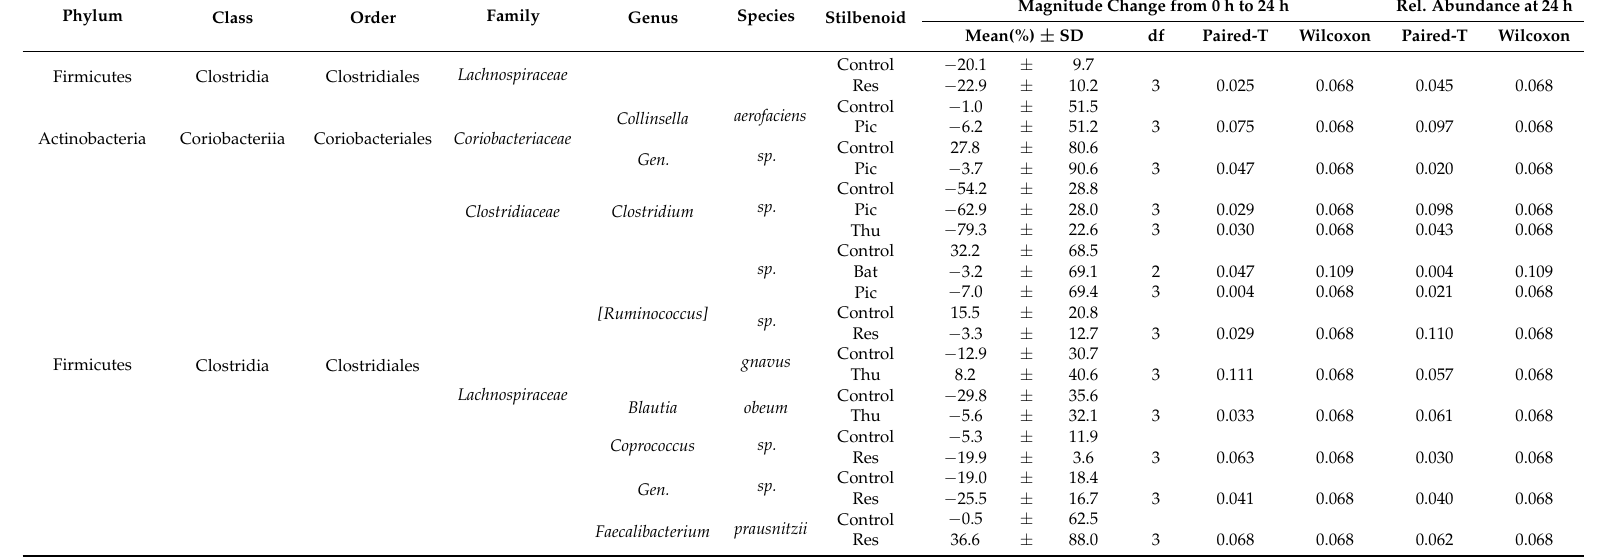
Table A2. Taxa that displayed p < 0.075 for at least one p value (Paired sample t-test and/or Wilcoxon signed-rank test) for both comparisons 1 and 2. Bolded p values are those <0.05 for the t-test, and ≤ 0.068 for the signed-rank test. Results from pairs with n ≤ 2 were excluded, which includes all pinostilbene samples. See materials and methods section for more details. Bat, batatasin III; Oxy, oxyresveratrol; Pic, piceatannol; Pino, pinostilbene; Res, trans-resveratrol; Thu, thunalbene. Gen. = unnamed genus, sp. = unnamed